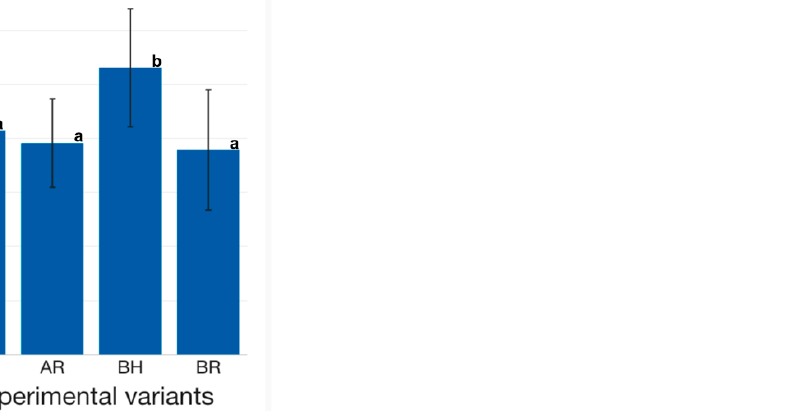
Figure 26. The N-NO 2 reduction rate and SE for each of the experimental variants (Tukey test)— different letters reveal significant statistical differences ( p < 0.05), whereas the same letter reveal not significant statistical differences ( p > 0.05).